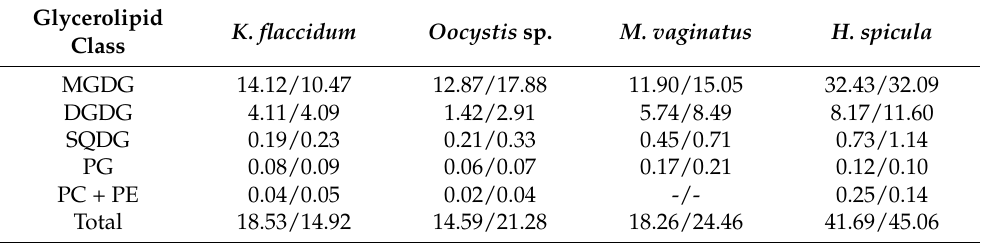
Table 3. Unsaturation index (UI = [No. of double bonds in fatty acyls] × [GL content]/[Chla content]) calculated for the different glycerolipid classes and the sum of them for the four organisms studied here. Values are given for LL/HL light conditions. K, Klebsormidium ; M, Microcoleus ; H, Haslea